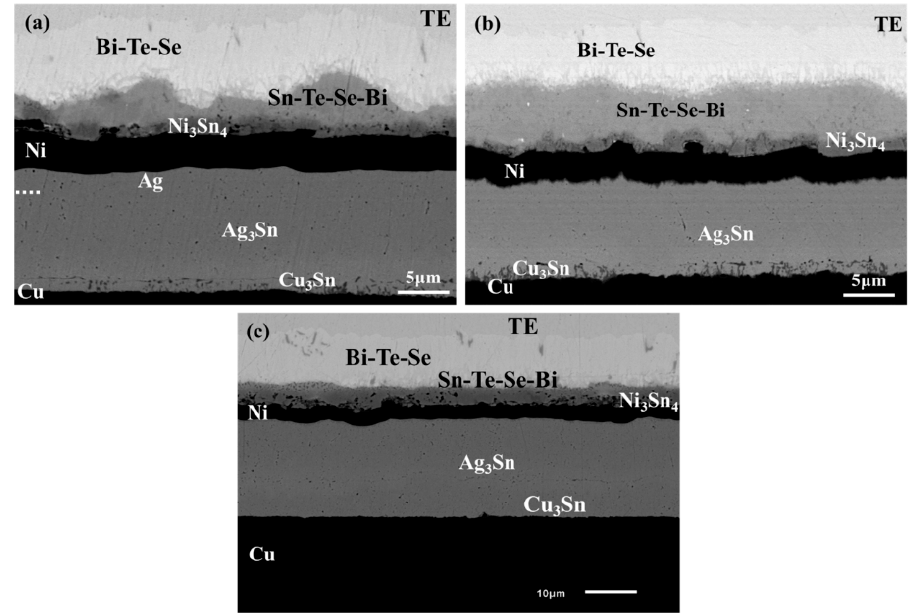
Figure 5. Morphology of intermetallic compounds formed after diffusion soldering between Bi 2 Te 2.55 Se 0.45 thermoelectric material and the Cu electrode with Sn interlayers at various temperatures for 60 min: ( a ) 250 °C, ( b ) 300 °C, ( c ) 325 °C. The thicknesses ( X ) of these intermetallic layers that formed at various temperatures were measured and are plotted in Figure 6a–8a as a function of bonding time ( t ). For the kinetics analyses, Ln X versus Ln t is plotted in Figure 6b–8b. The growth exponents ( n ) for Sn–Te–Se–Bi intermetallic layers calculated from the slopes of straight lines in Figure 6b ranged from 0.34 to 0.55. Similarly, the n values of and Ni 3 Sn 4 growth calculated from the plots in Figure 7b ranged from 0.35 to 0.50. It is evidenced that the growth exponents ( n ) for both the Sn–Te–Se–Bi and the Ni 3 Sn 4 intermetallics were close to that of a diffusion-controlled reaction ( n = 0.5). However, the growth exponents ( n ) for the Ag 3 Sn intermetallic layers, as shown in Figure 8b, ranged from 0.10 to 0.17, which are inconsistent with that of a diffusion mechanism. This discrepancy can be attributed to the release of partial Sn atoms in the Ag 3 Sn intermetallic layers to react with the Cu electrodes to form Cu 3 Sn intermetallic compounds after the exhaust of the Ag films on the Cu electrodes.